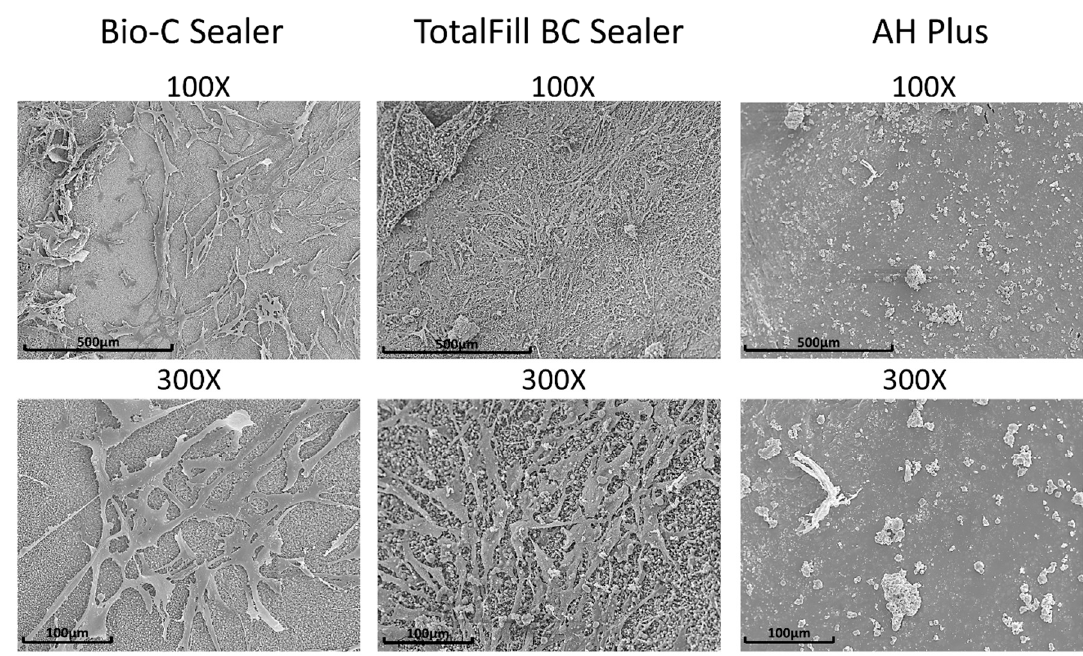
Figure 4. The morphology of hPDLSCs attached on the surface of Bio-C Sealer, TotalFill BC Sealer and AH Plus after culture for 3 days at a magnification of 100× and 300×. Scale bar: 500 μ m and 100 μ m.